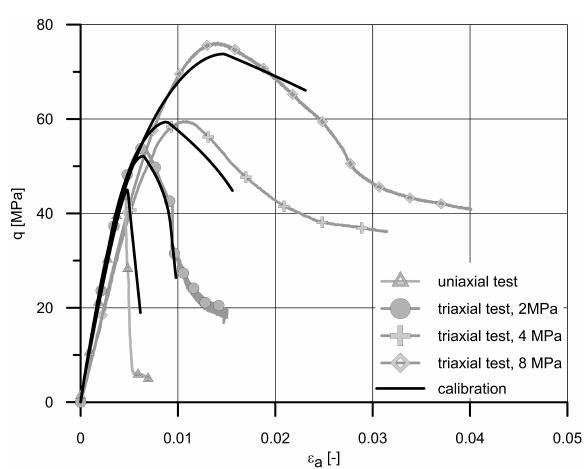
Figure 5. Measured and predicted stress – strain curves for profile